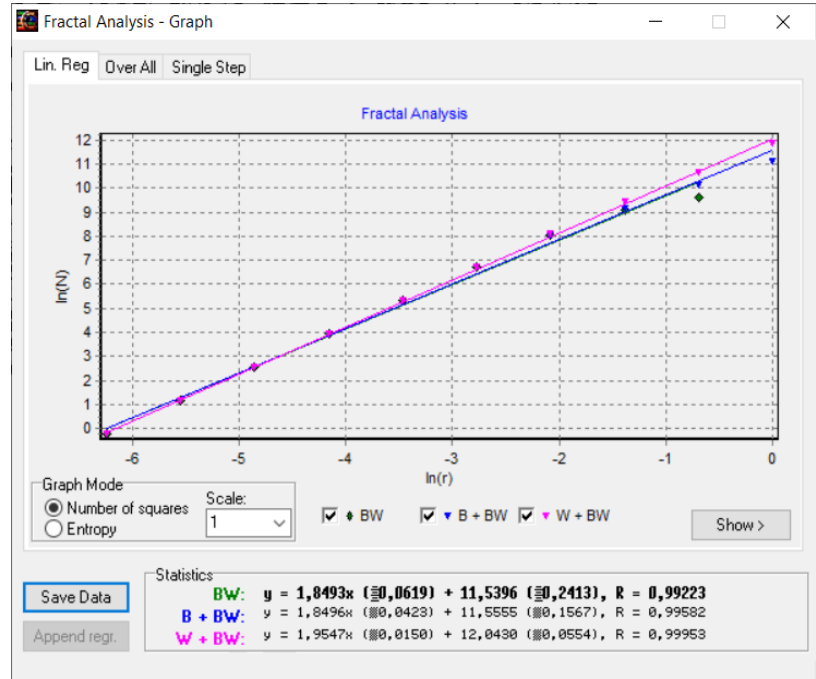
Figure 13. Graphic of fractal dimension for elected P 2 picture zone.